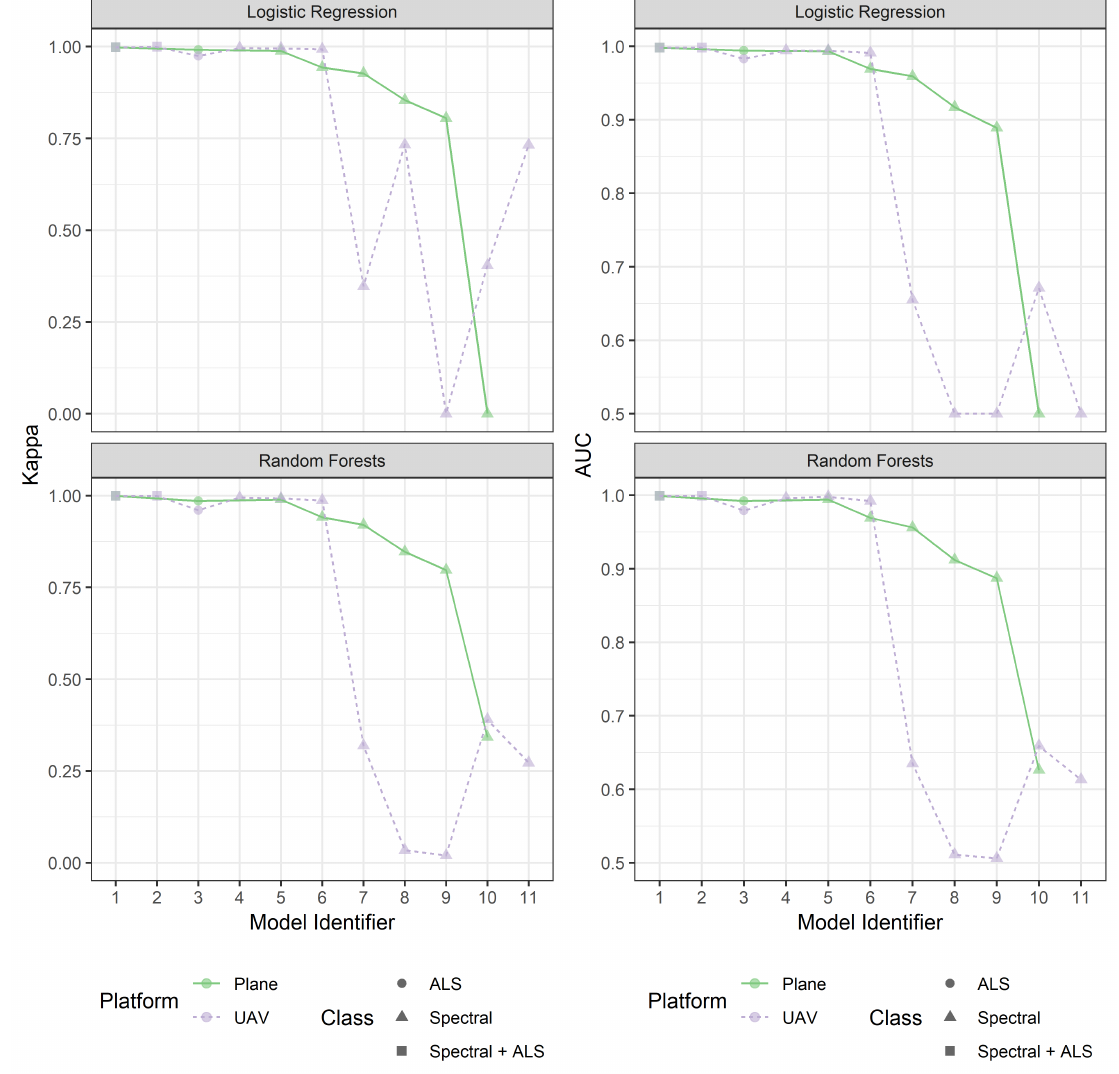
Figure 5. Kappa values extracted from the cross-validation results during model development. Each datum represents the kappa value from cross-validation for a single model. The model identifiers as shown in Table 1 are shown along the X axis and shape of each datum represents the class of model represented. Please note that models 2 and 11 could only be developed using UAV data as these included the red edge